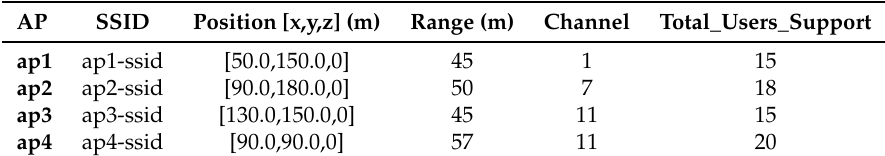
Table 2. Access Point (AP) setup.